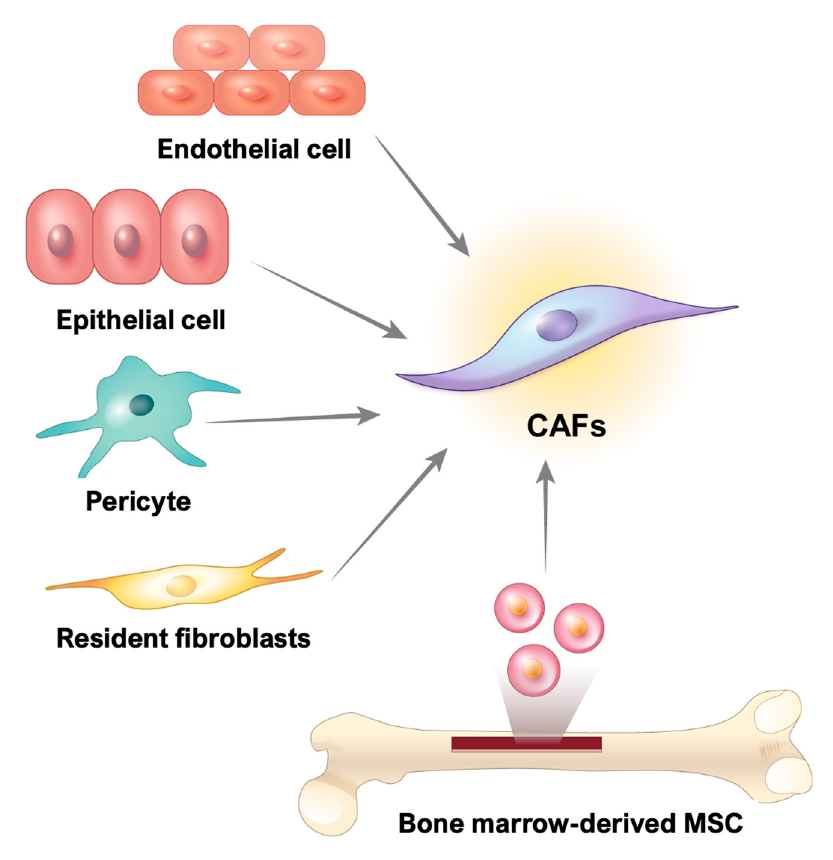
Figure 2. Origins of cancer-associated fibroblasts (CAFs). Sources of CAFs in gastrointestinal cancers include resident fibroblasts, endothelial cells, epithelial cells, pericytes, and bone marrow-derived mesenchymal stem cells. CAFs: cancer-associated fibroblasts, MSC: mesenchymal stem cell.